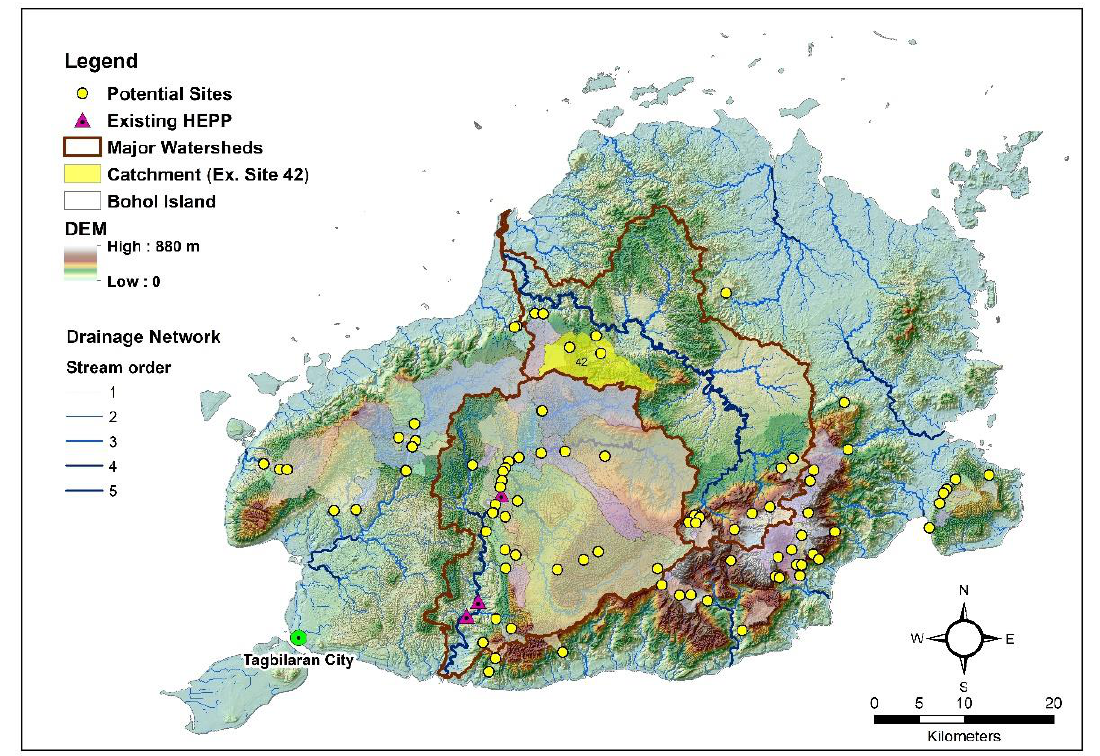
Figure 7. Spatial distribution of potential small-scale hydropower sites identified through topographic analysis, the stream order, corresponding catchment, and the drainage network.